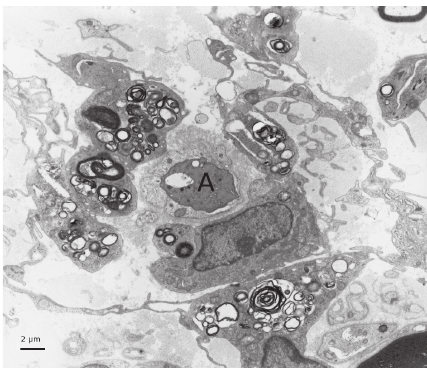
Figure 2: A naked axon (A) is surrounded by several macrophages loaded with myelin debris in a patient with the CIDP-like profile. Electron micrograph, transverse